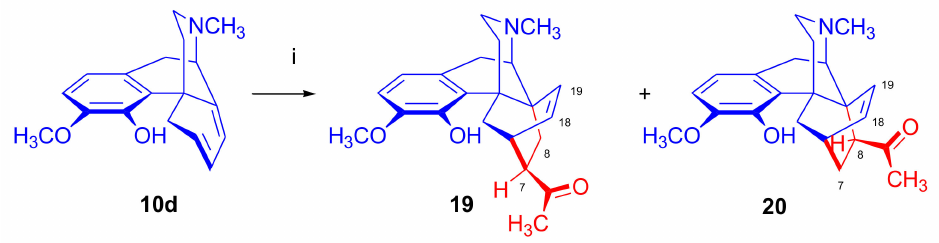
Figure 8. Cycloaddition of methyl vinyl ketone to 6-demethoxy- β -dihydrothebaine. Reagents and conditions : (i): methyl vinyl ketone, benzene, reflux, 24